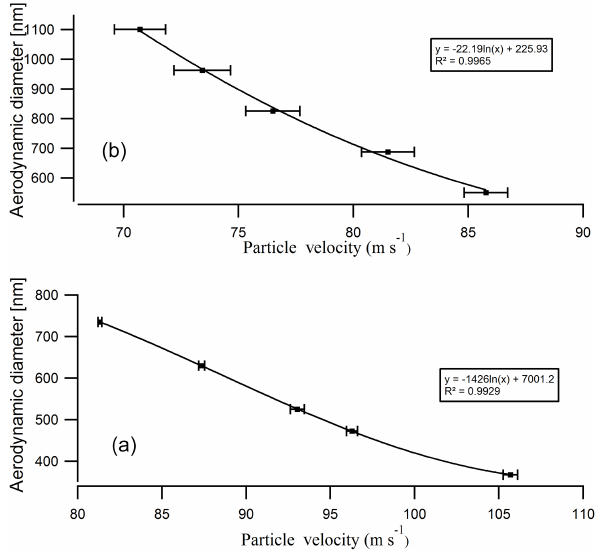
Figure 11. Plot of aerodynamic particle size versus particle velocity for (a) PSL particles and (b) ammonium nitrate particles.